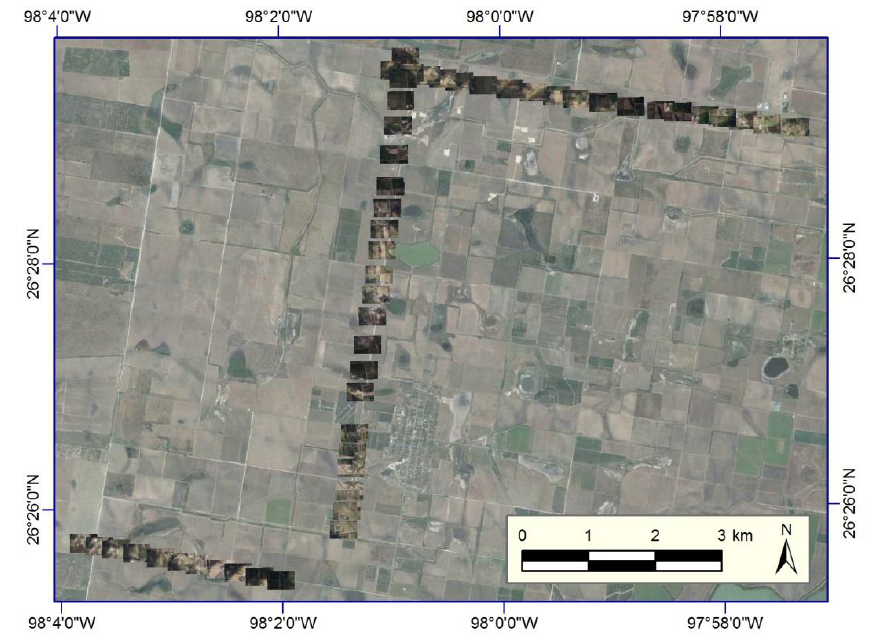
Figure 3. Geotagged images plotted in Google Earth. The images were acquired at 610 m (2000 ft) above ground level near Hargill, Texas on 14 May